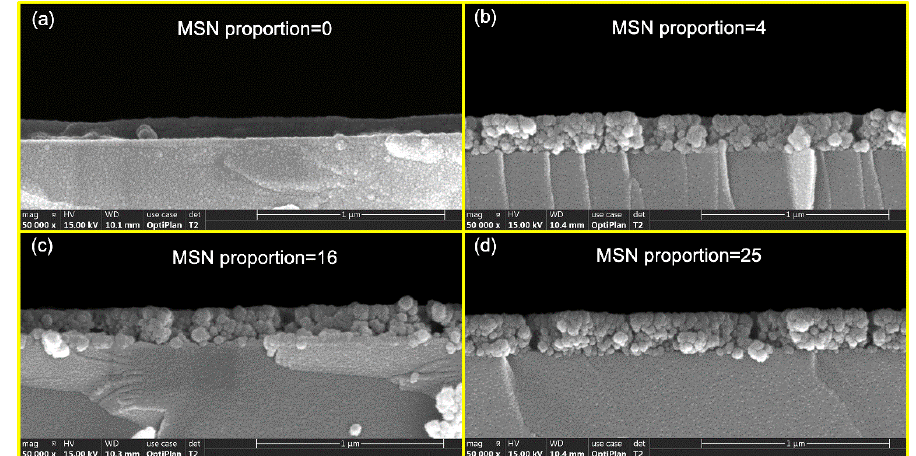
Figure 4. Cross-sectional SEM images of polysiloxane coatings with different MSN embedding proportions, ( a ) with MSN proportion of 0, ( b ) with MSN proportion of 4, ( c ) with MSN proportion of 16, ( d ) with MSN proportion of 25.